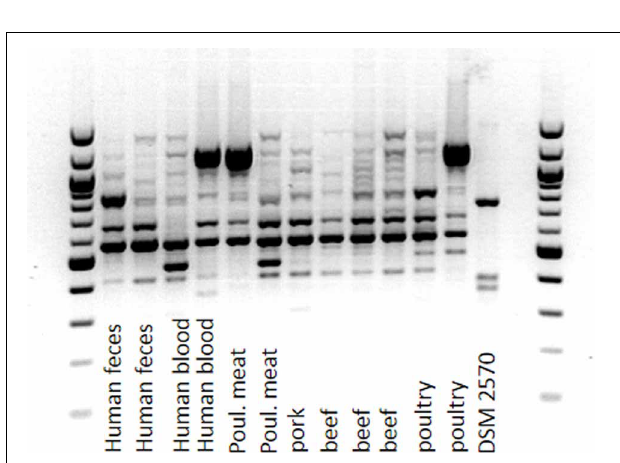
FIGURE 2 | Amplicon-typing (RAPD-PCR) of E. faecalis (MIC of DDAC > 1.4mg/l) from different sources.